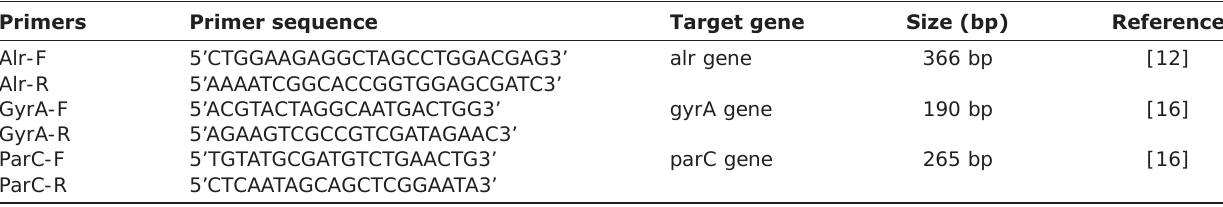
Table-1: Oligonucleotide primer sequence used for amplification of the following target gene in this study.